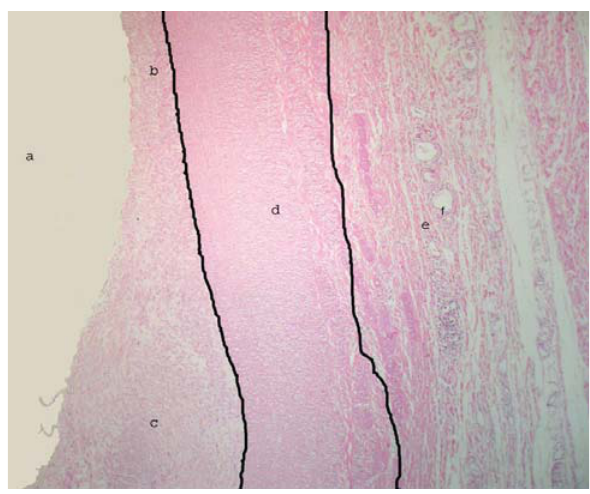
Fig. 2 - Visão externa da aorta abdominal com uma haste metálica do stent (flecha) passando sobre o óstio da artéria renal, sem sinais de obstrução